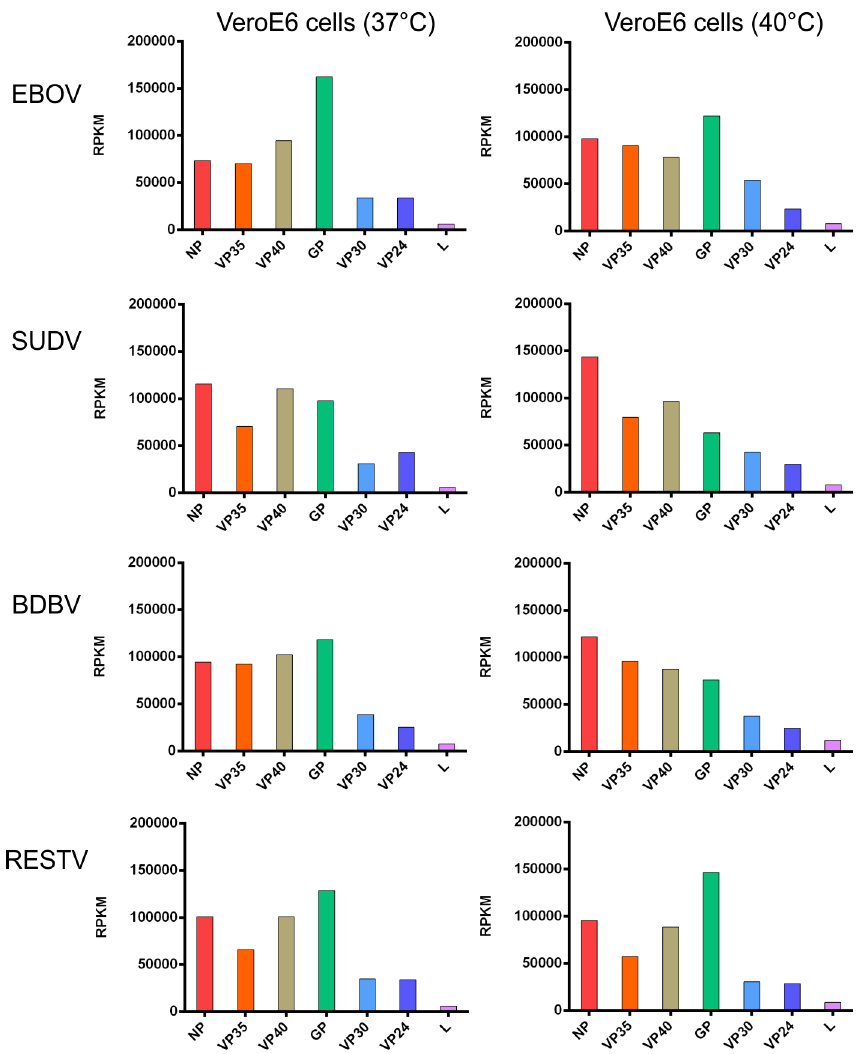
Fig 3. Effects of incubation temperature on viral mRNA levels. Vero-E6 cells were infected with EBOV, SUDV, BDBV, or RESTV at moi (cid:21) 2. After 1 h of virus adsorption at 37˚C, infected cell cultures were incubated at 37˚C or 40˚C. Infected cells were harvested at 1 dpi. NGS libraries and RPKM analysis were done as in Fig 1.